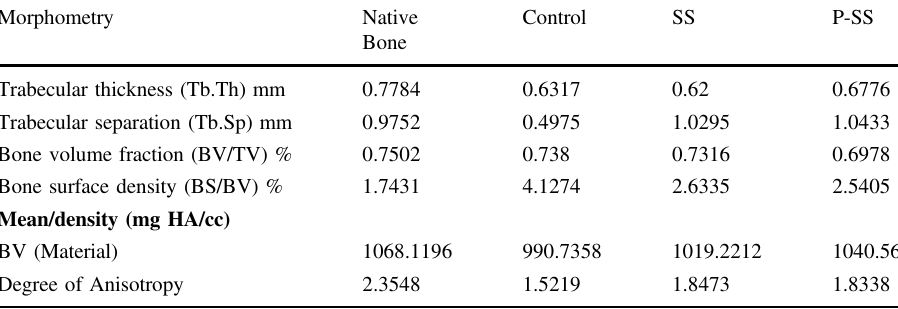
Morphometry Native